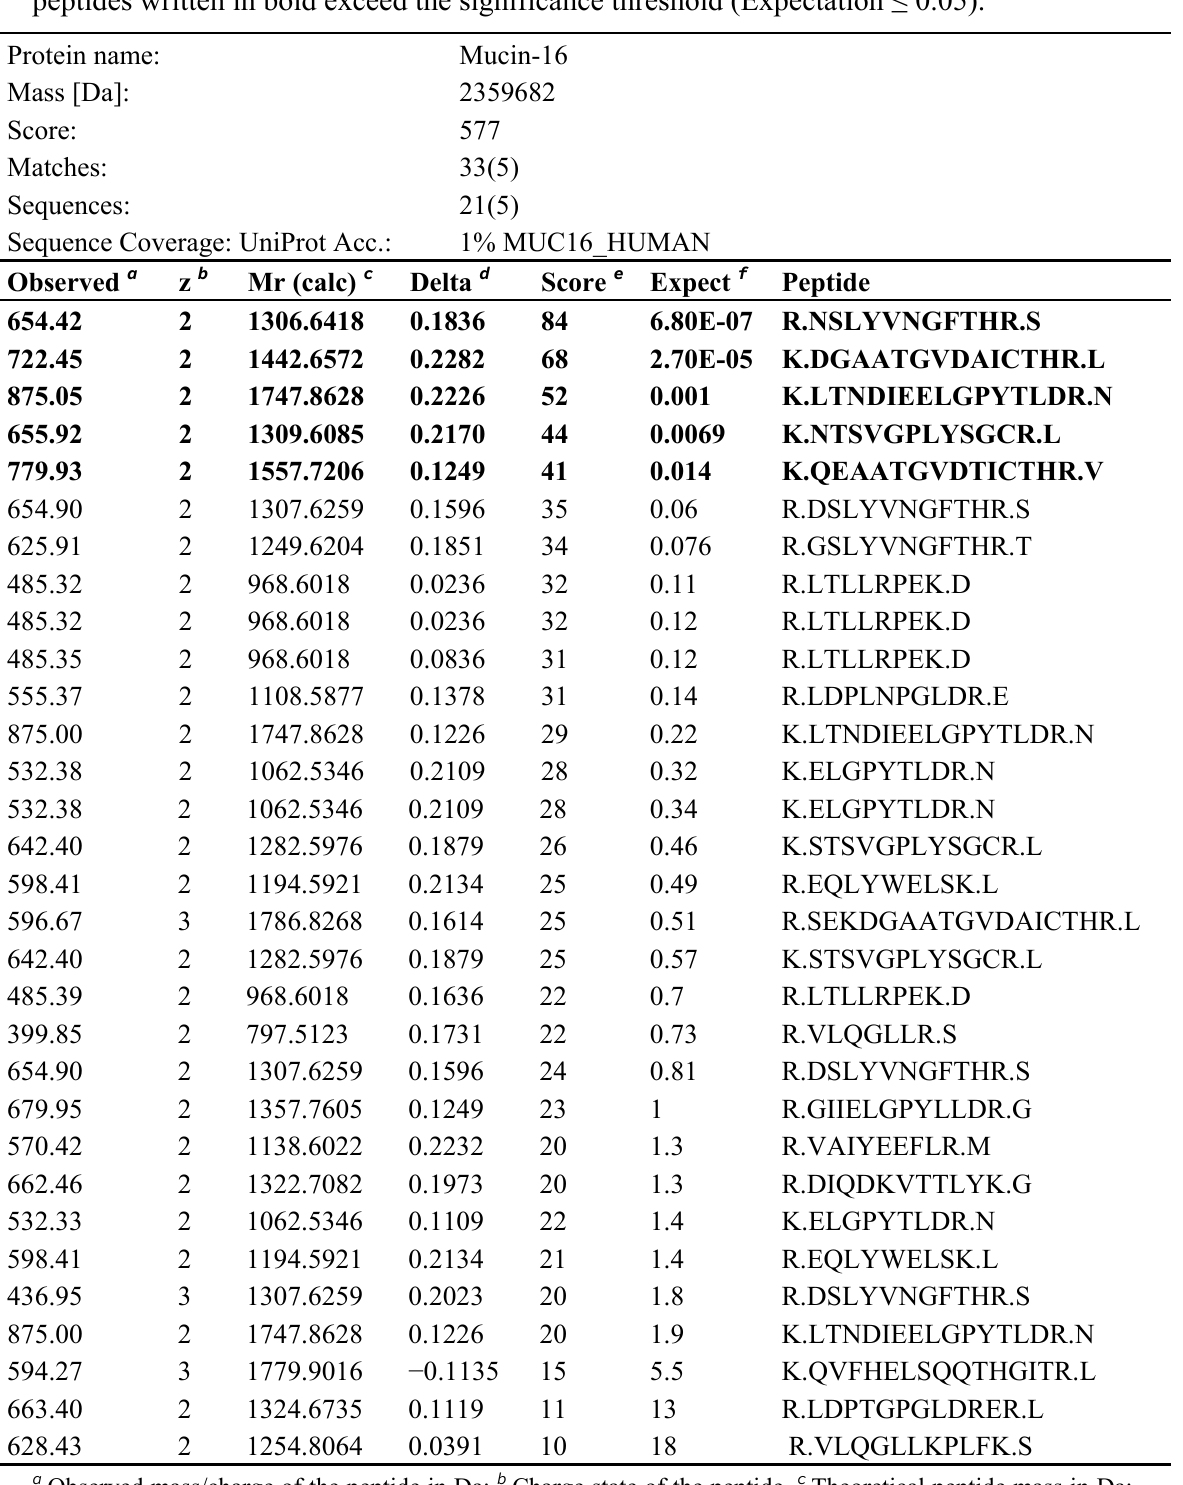
Table 1. MASCOT search results for peptides of CA125 from SDS-PAGE gel band IV (Figure 1B) identified by a HCT Ultra 3D Ion Trap mass spectrometer. The score of the peptides written in bold exceed the significance threshold (Expectation ≤